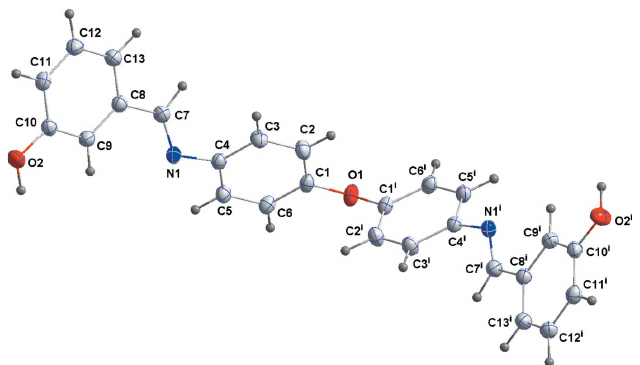
Figure 1 The title molecule with labeling scheme and 50% probability ellipsoids [symmetry code: (i) (cid:5) x + 1, y , (cid:5) z + 1